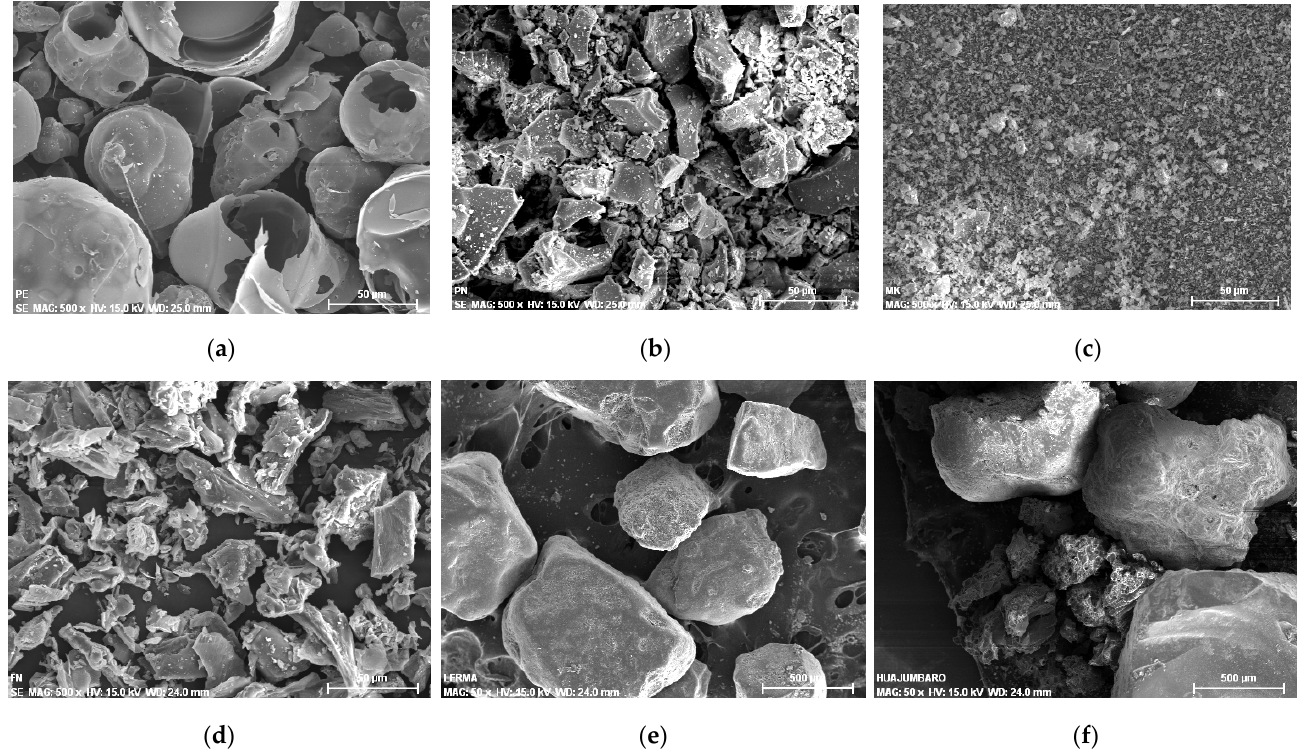
Figure 6. SEM images of the substitution materials. ( a ) SBA; ( b ) CA; ( c ) BMA; ( d ) BFA; ( e ) BA; ( f ) C.